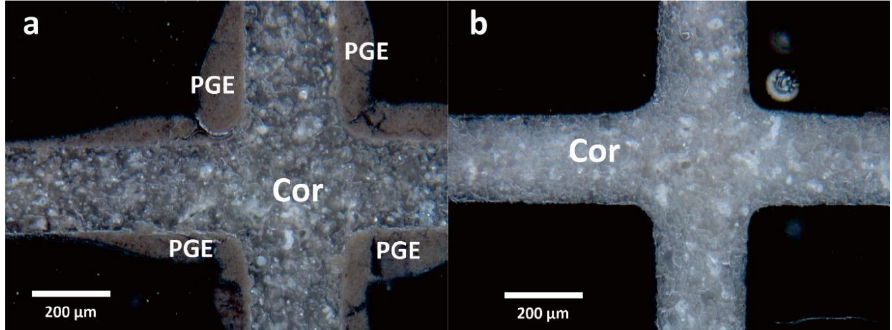
Figure 3. Metallographic observation on catalytic converters mounted on resin ( a ) before and ( b ) after fusion using potassium bisulfate, followed by leaching using hydrochloric acid 5 M. (Cor: cordierite matrix; PGE: platinum group element coating).